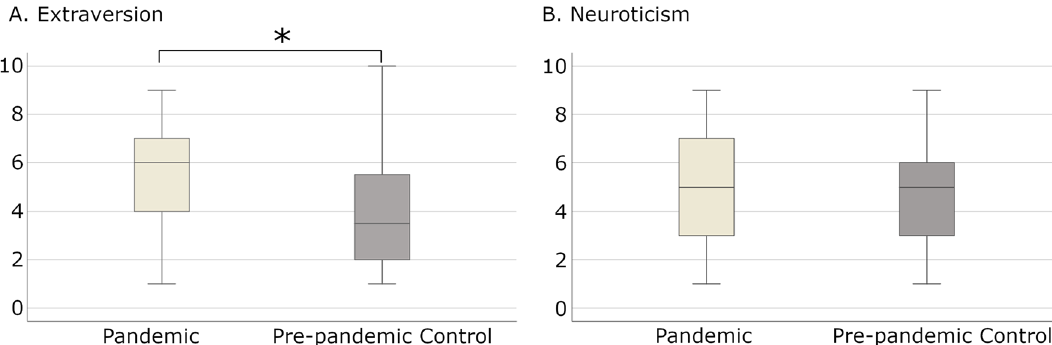
Figure 1. Comparison of level of extraversion ( A ) and neuroticism ( B ) on the sten score scale between Pandemic and Pre-pandemic Control groups in Session-1. The asterisk denotes a significant difference between groups ( p < 0.05 Mann–Whitney test). Created using R 4.0.4 (https:// www.r- proje ct.